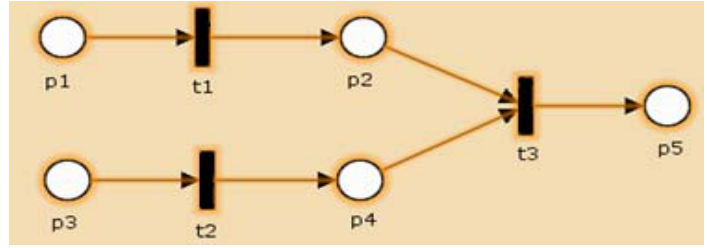
Fig. 1. A simple Petri net (Reisig,